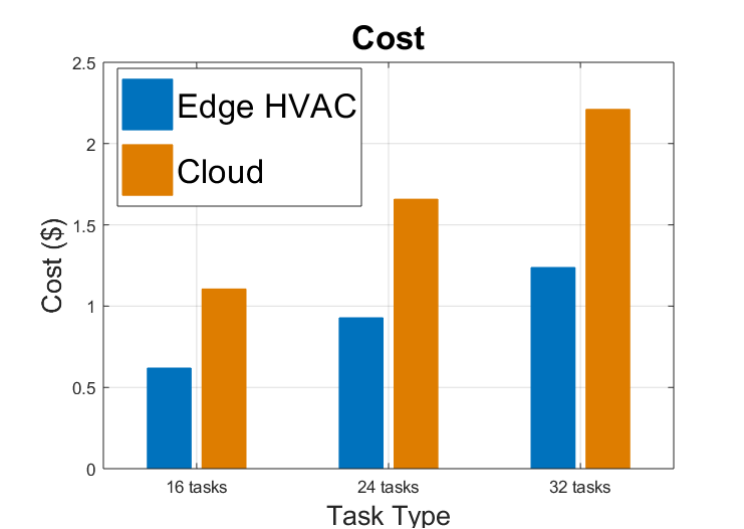
Figure 3. Cost with edge HVAC and